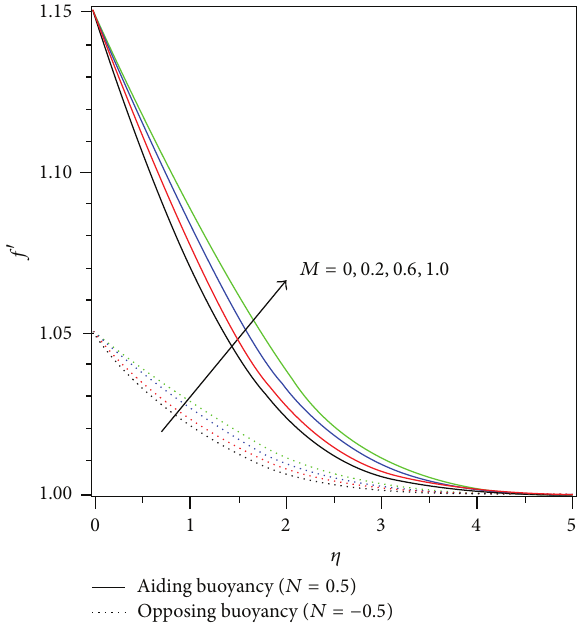
Figure 5: Velocity profile for both aiding and opposing buoyancy for different values of 𝑀, Df = 0.02 , Sr = 0.2 , Gr / Re = 0.1 , and Le = 1.0